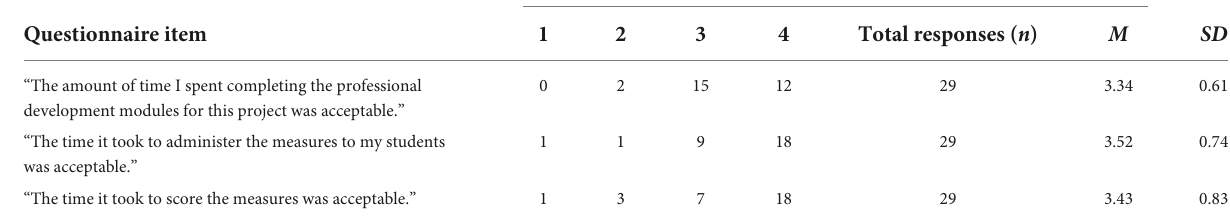
Frequency of response by